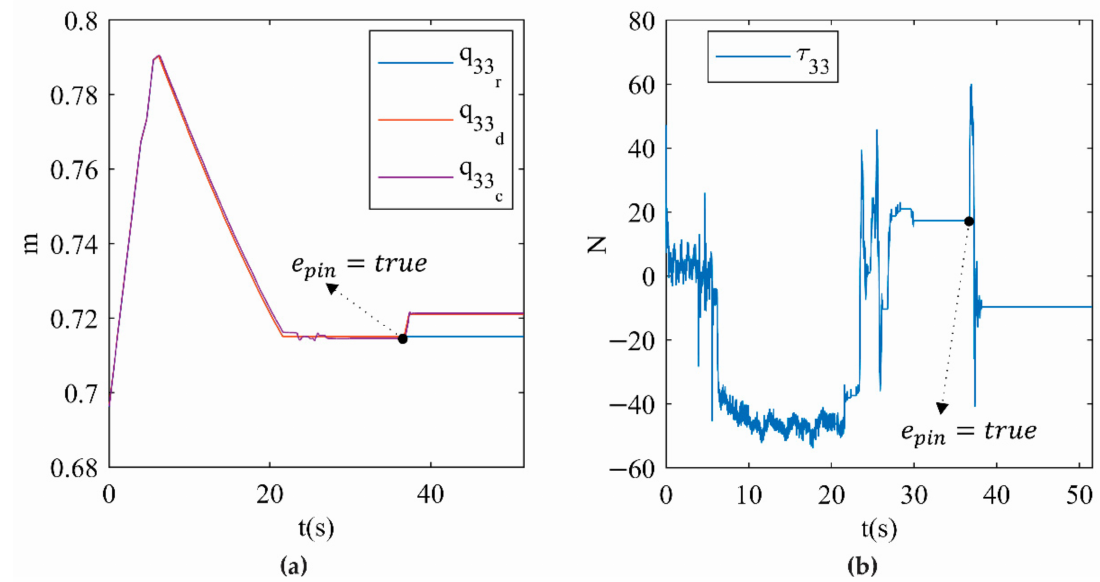
Figure 13. ( a ) q ind ( b ) τ on limb 3 for trajectory